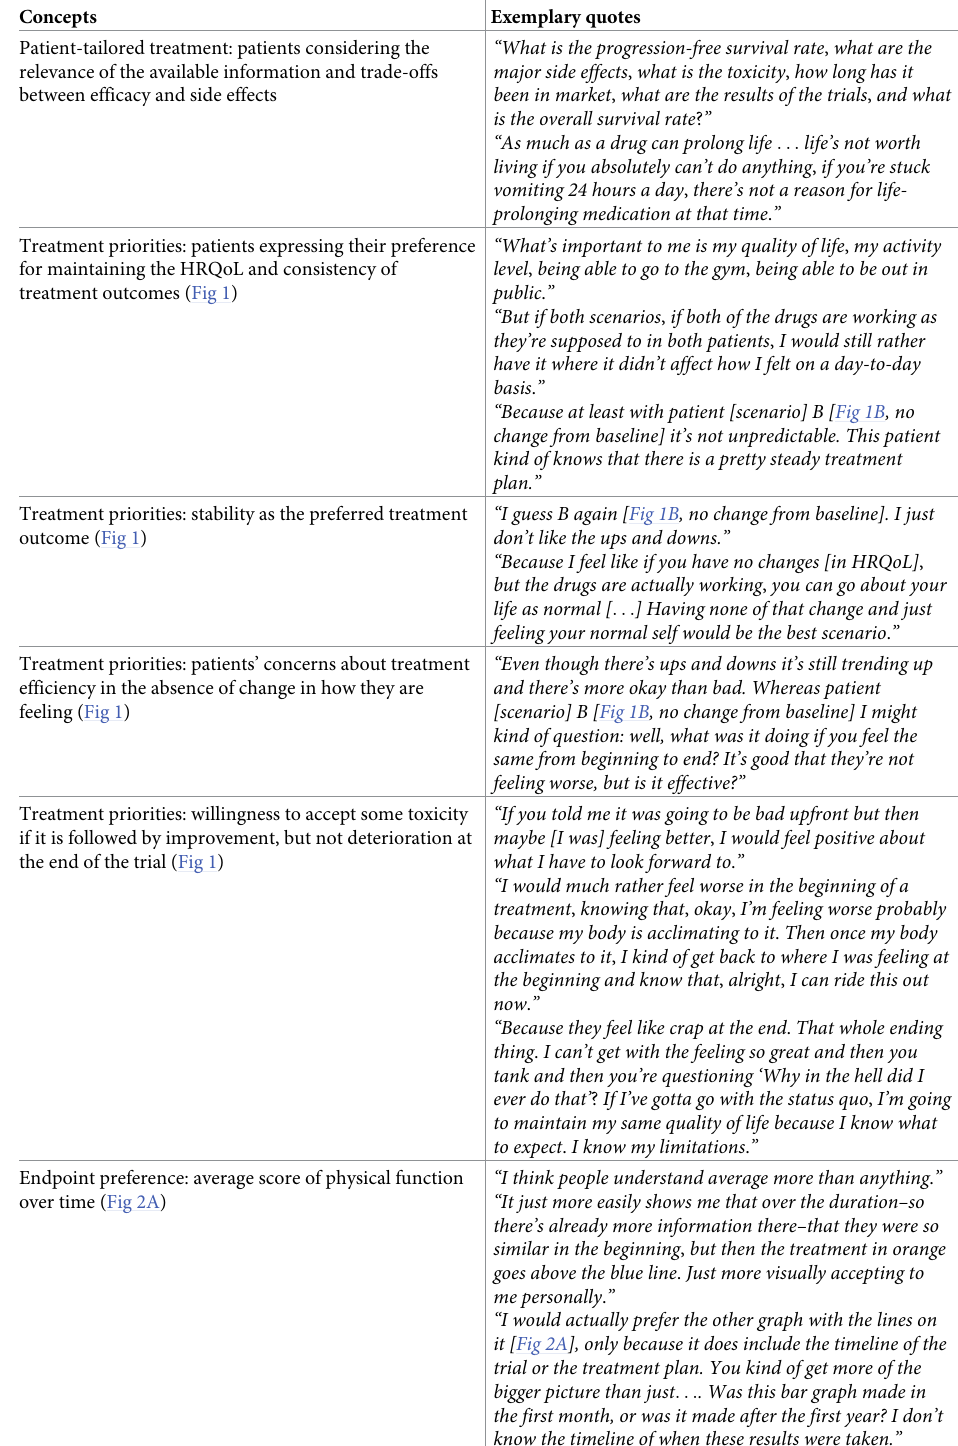
Table 3. Exemplary